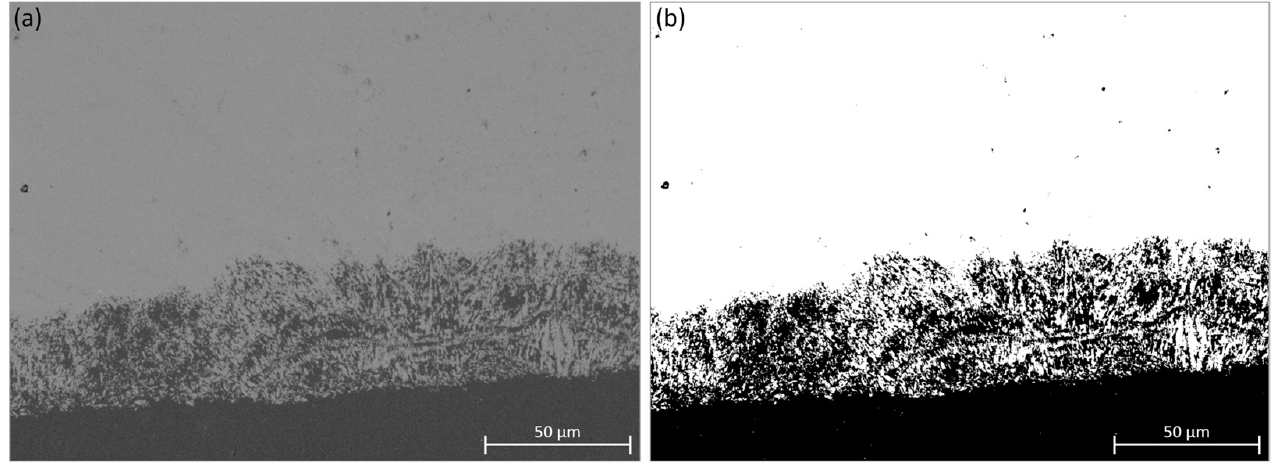
Figure 3. Examples of image transformation from ( a ) scanning electron microscope image to ( b ) binary image for porosity calculation using ImageJ [34].